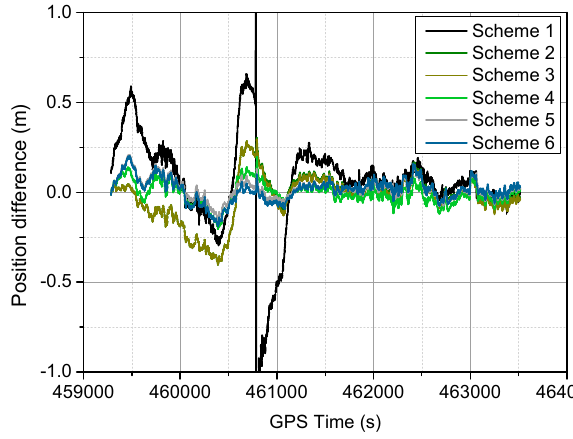
Figure 8. Height position difference for different schemes.